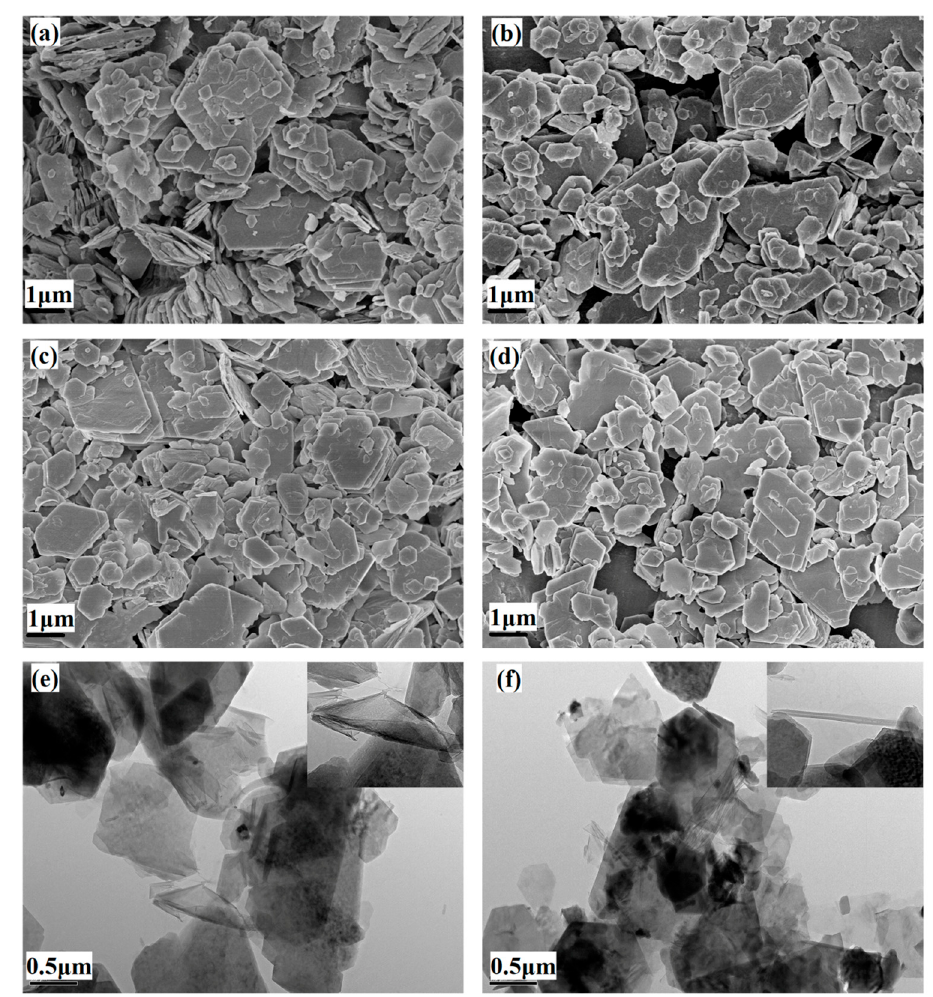
Figure 4. SEM images of ( a ) Kaol, ( b ) Kaol-MeOH, ( c ) Kaol-SDS and ( d ) Kaol-SDS-U; TEM images of ( e ) Kaol-SDS and ( f ) Kaol-SDS-U.